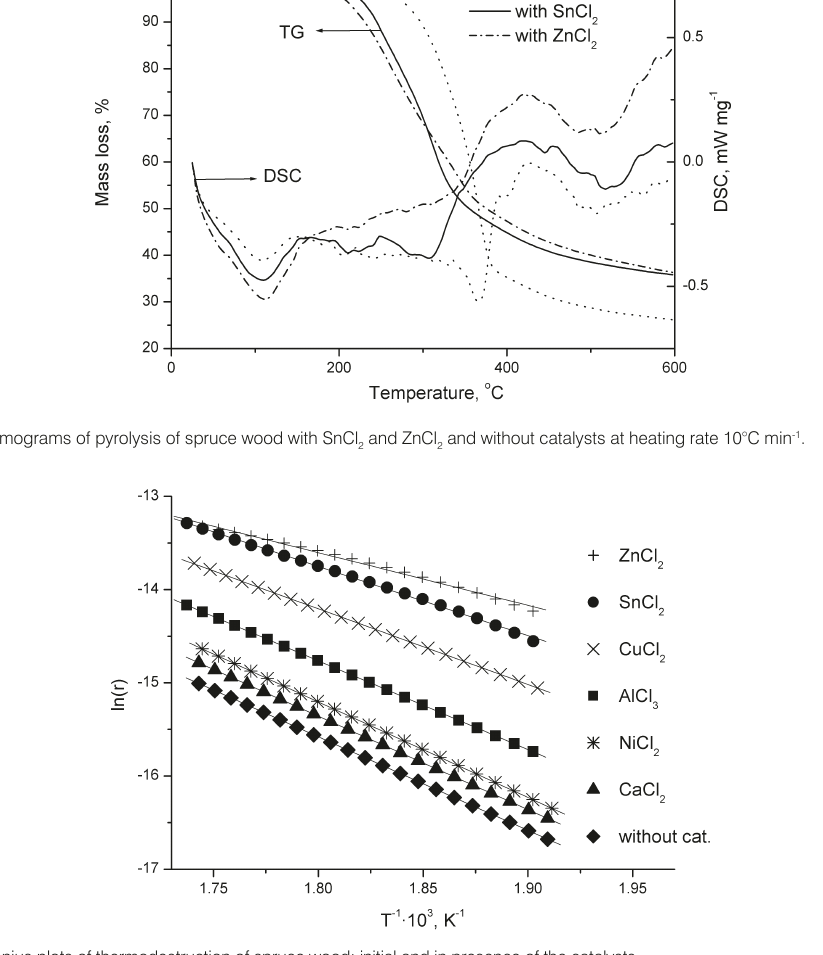
Figure 5. Arrhenius plots of thermodestruction of spruce wood: initial and in presence of the catalysts. Table 4. Kinetic parameters of the pyrolysis of spruce wood in the temperature range